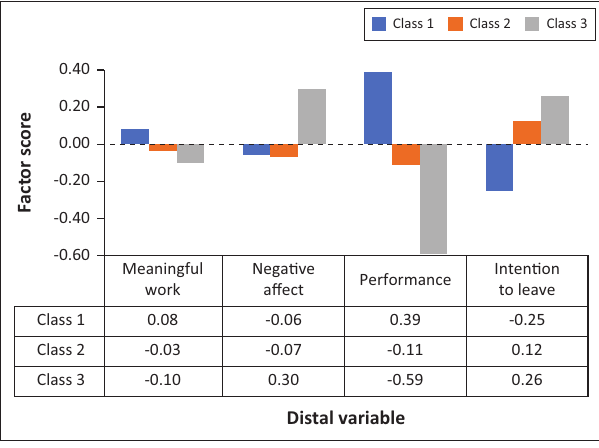
FIGURE 2: Capability classes and scores on